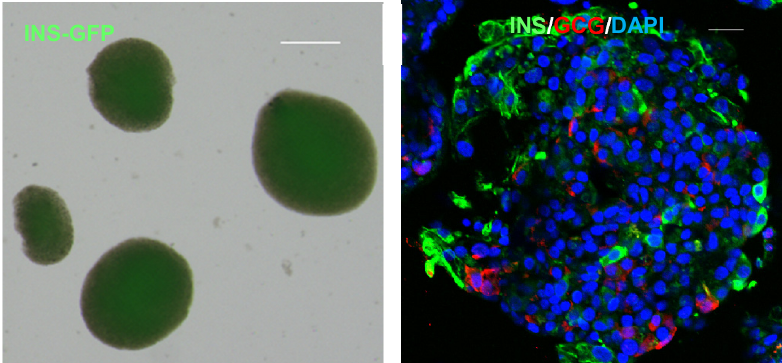
Figure 1. Human pluripotent stem cells (hPSCs)-derived pancreatic islets. Live-cell imaging (left) and immunofluorescence (right) of hPSCs-derived pancreatic islet organoids. GFP is expressed under the insulin promoter. Cells are stained with antibodies to insulin (green), glucagon (red) and DAPI (blue). The scale bars in both panels represent 20 μ m.